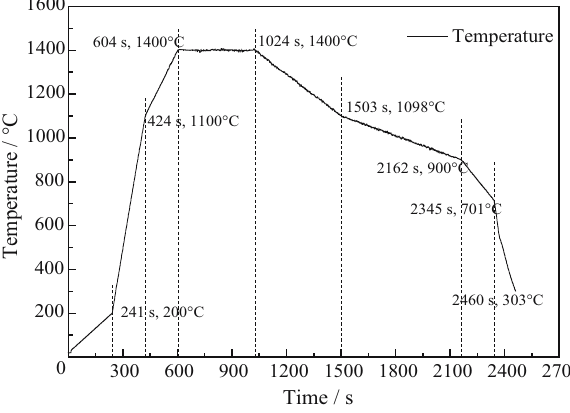
Figure 11: Function of temperature varying with time for the in situ analysis.